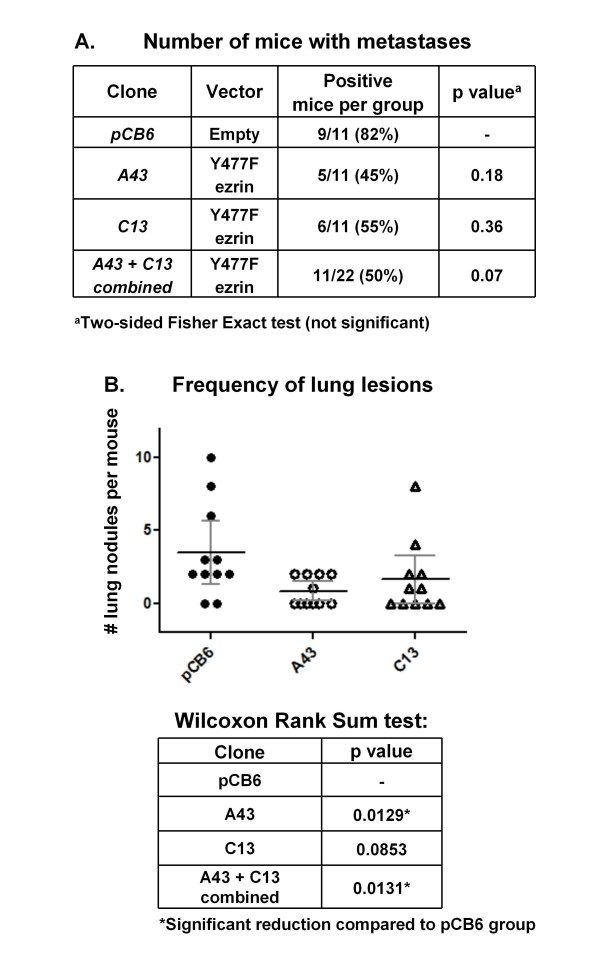
Effect of the expression of Y477F ezrin on lung metastasis formation. Mice from which primary tumors were removed (corresponding to Additional file 2: Figure S2) were allowed to survive for 20 additional days to allow overt metastases to form. Serial sections (5 μm) of FFPE processed lung tissues were stained with hematoxylin and eosin for histopathological assessment. At least two sections from the superficial and middle planes, respectively, of each mouse lung were examined and the number of lung nodules per mouse was determined. Panel A) The table shows the proportion of mice with metastasis in each group. The incidence of mice with lung metastases from Y477F ezrin tumors (A43 and C13 clones) was reduced, but this difference did not achieve significance, as determined by a two-sided Fisher Exact test. Panel B) The number of lung nodules per mouse per group is represented as a dot plot. Statistical significance was determined by a Wilcoxon Rank Sum test. Mean +/- 95% confidence intervals (bars) is shown for each group. A significant reduction in the number of nodules per mouse with clone A43 tumors was observed (p = 0.0129). The number of lung nodules in C13 tumors was also reduced, but this value was not significant (p = 0.0853), due to one outlier. Analysis of pooled data showed a significant reduction in lung nodules in mice with A43 and C13 tumors combined, compared to mice with pCB6 tumors (p = 0.0131).